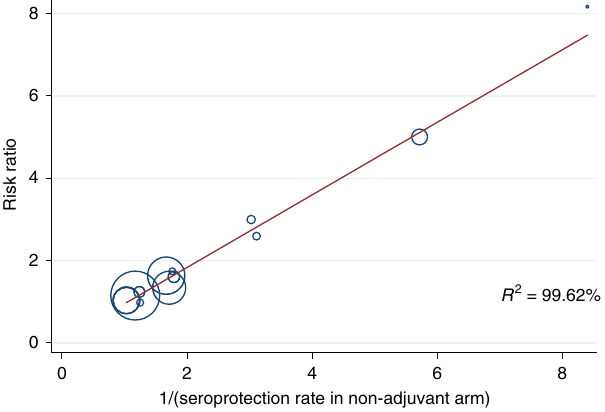
Fig. 8 Meta-regression showing a linear relationship (slope = 0.88, P < 0.001) between the ratios of the seroprotection rate against B after the second dose and the inverse of seroprotection rate in non-adjuvanted arm, with an R 2 of